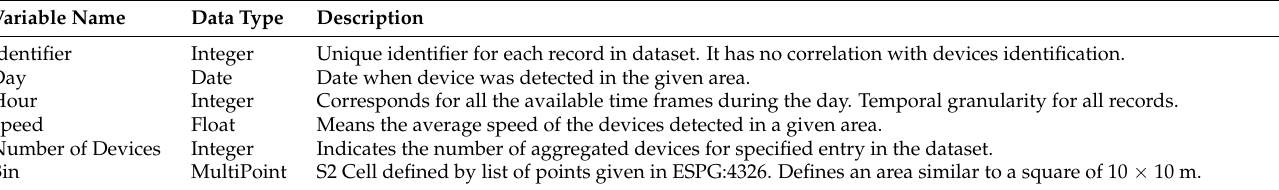
Table 1. Data structure and meaning of each